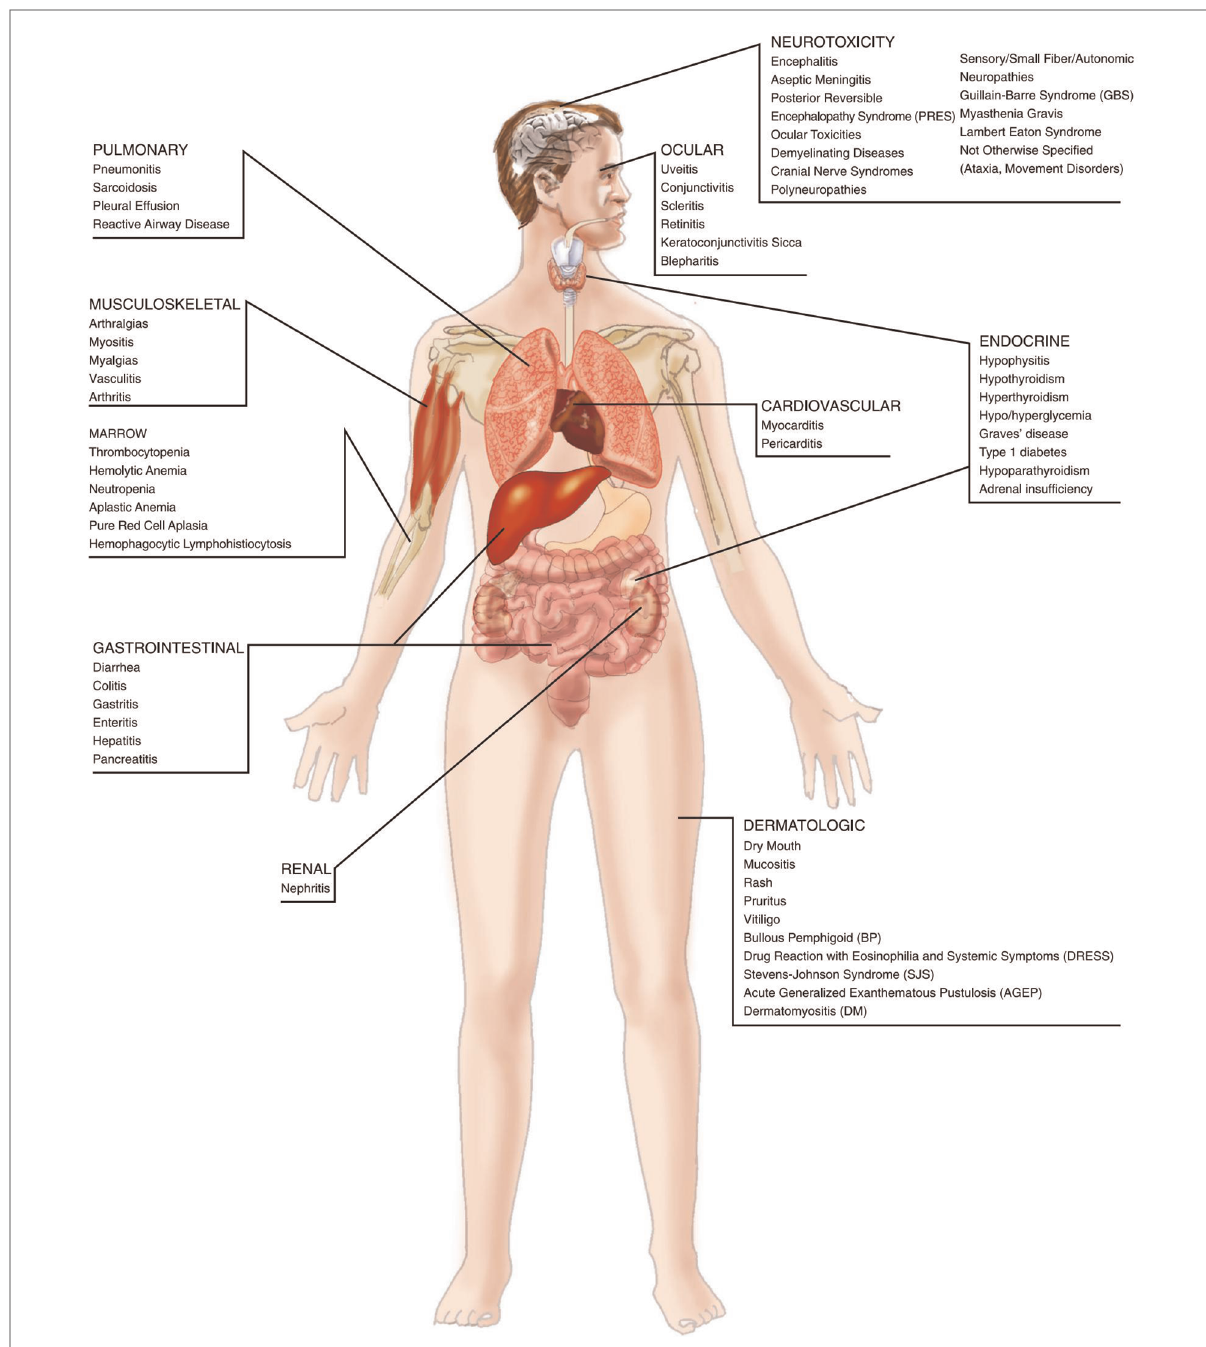
FIGURE 3 Diagram of immune checkpoint inhibitor-related toxicities